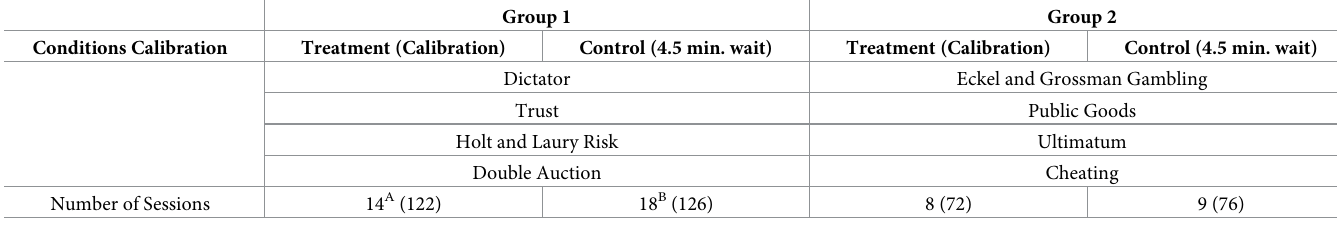
Table 1. Experimental sequence for Groups 1 and 2 including the number of sessions and observations between treatment